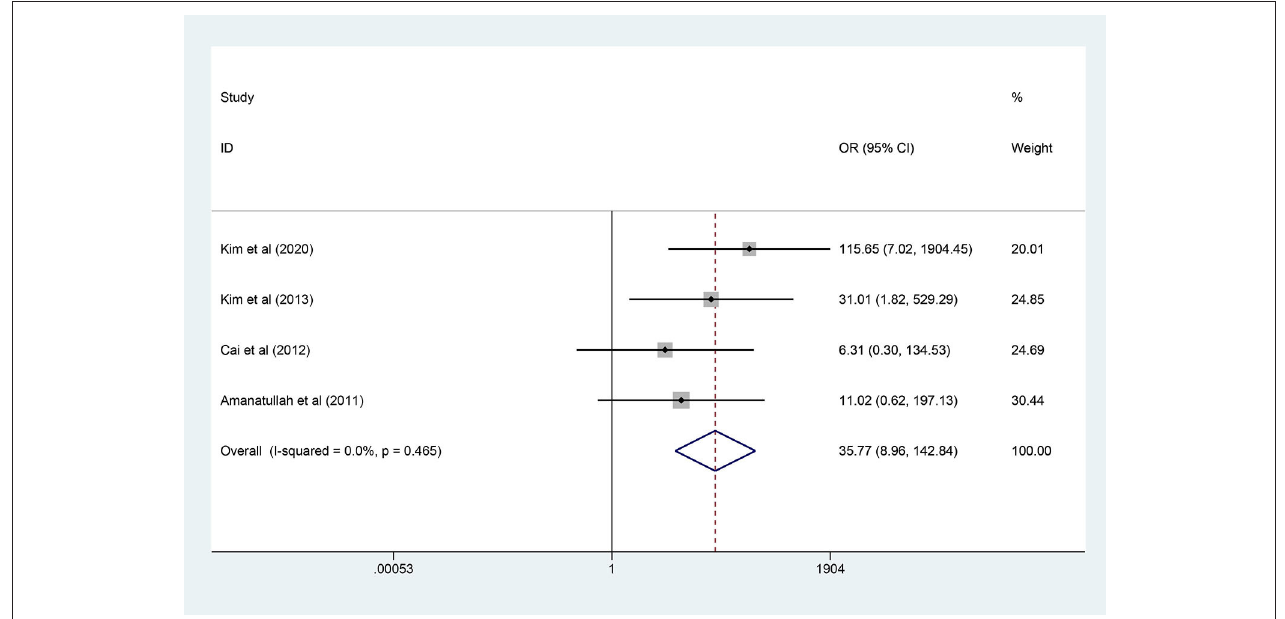
A total of 9 studies (1,037 hips) reported prosthesis loosening events and a fixed-effects model was used owing to non- significant heterogeneity among the studies ( I 2 = 0.0%, p